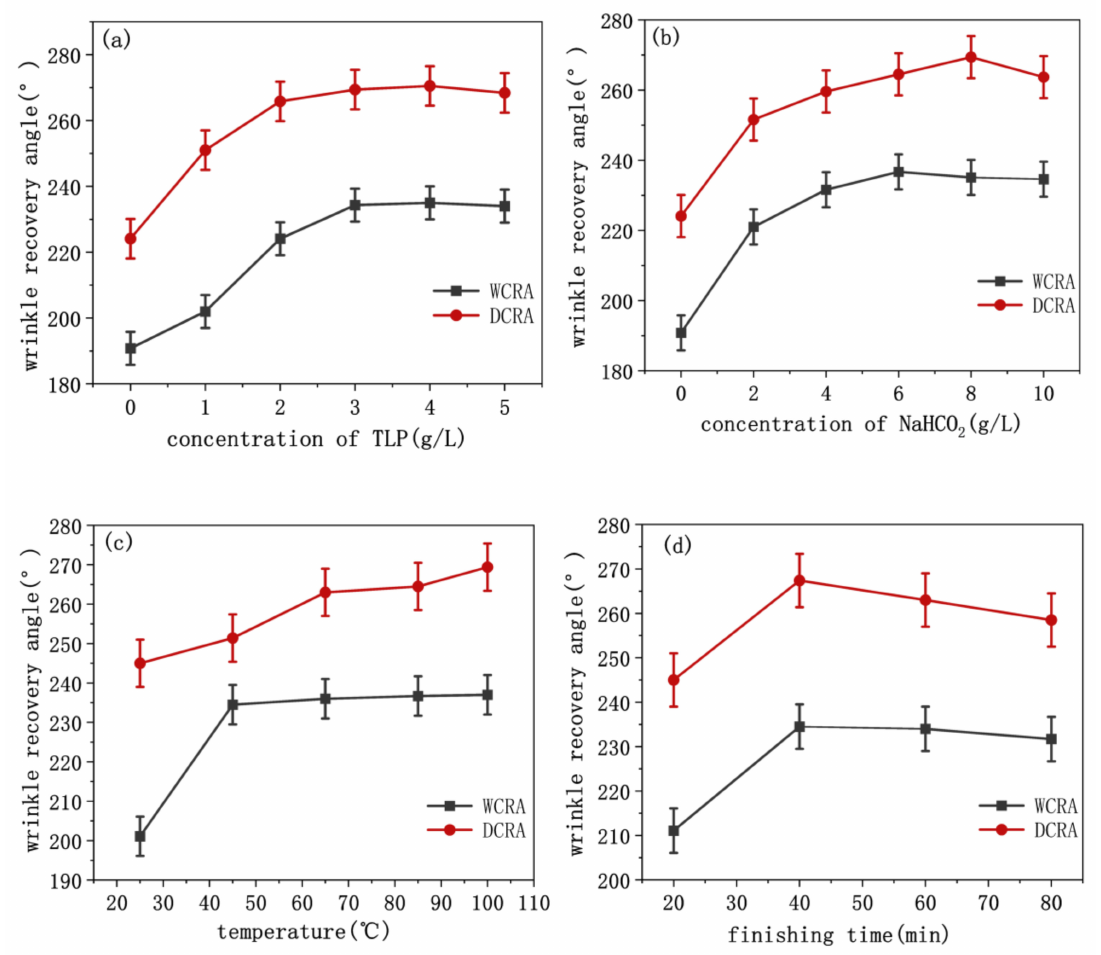
Figure 2. Effects of reaction condition on anti-wrinkle of TLP-finished silk fabric. ( a ) Concentration of TLP dispersions; ( b ) concentration of NaHCO 2 ; ( c ) finishing temperature; ( d ) finishing time.